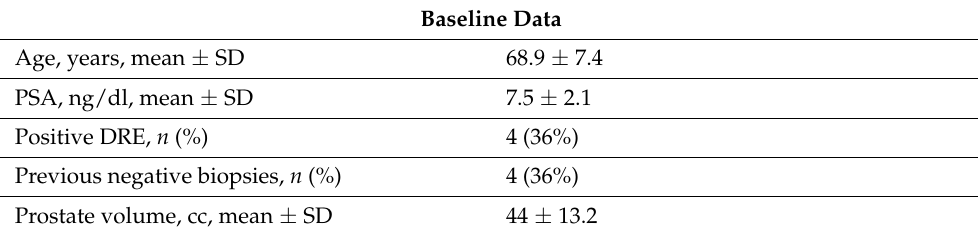
Table 1. Patients’